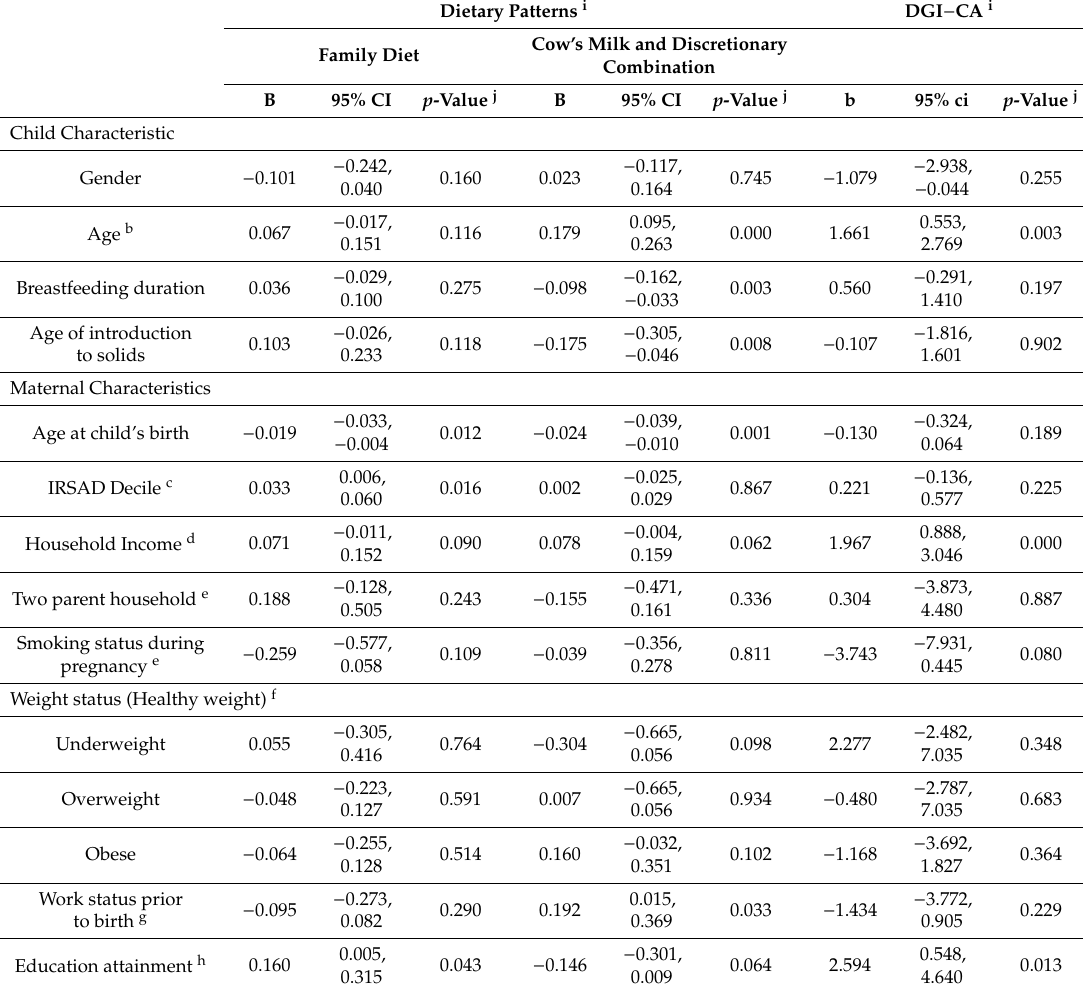
Table 5. Multivariable associations with dietary patterns at 12 months and mother-child dyad characteristics, after adjusting for covariates ( n = 680) a